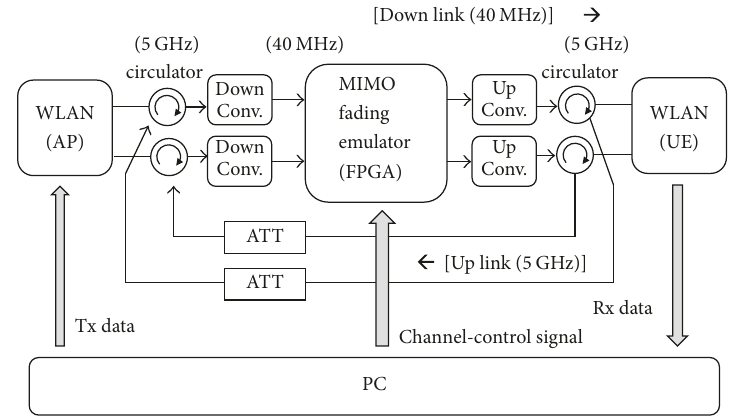
Figure 16: Experiment configuration for WLAN transmission characteristics assessment.